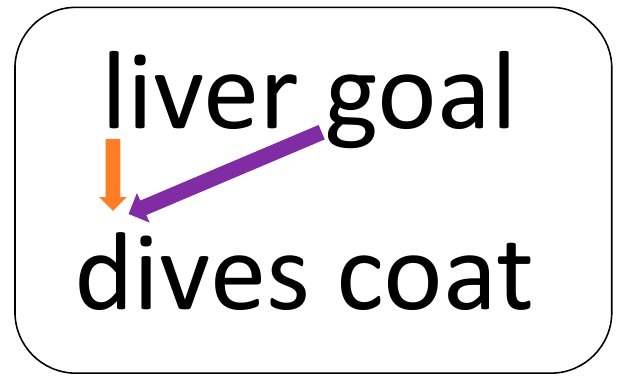
Figure 7. An example of vertical (orange) and diagonal (purple) possible migrations in two word- pairs placed one above the other. A vertical migration to the first letter of the target word dives creates “lives”; a diagonal migration would create “gives”.